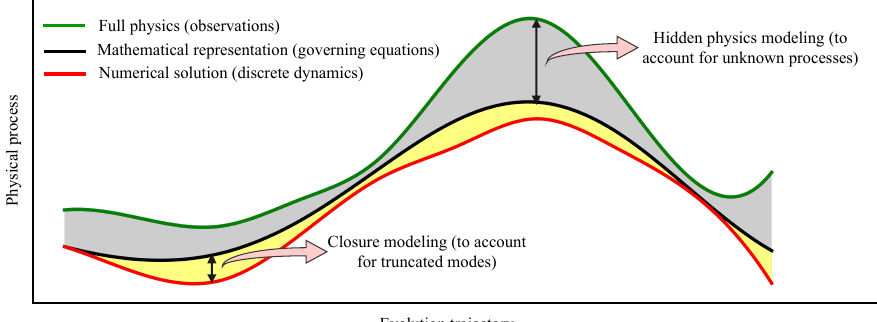
Figure 1. A conceptual illustration of the closure modeling and hidden physics modeling